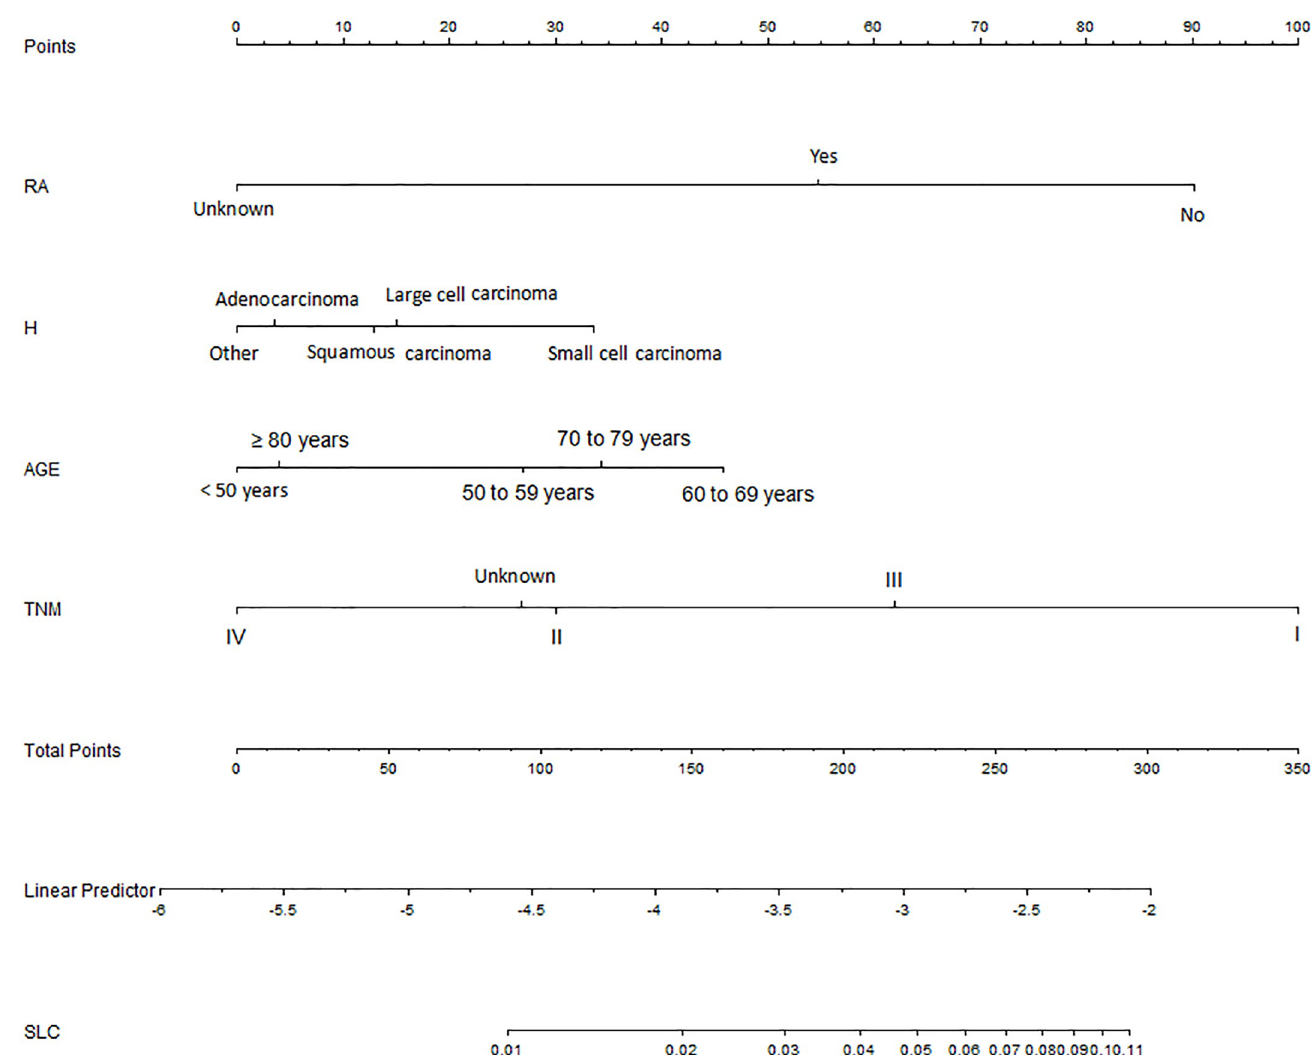
Fig 2. Risk prediction nomogram of metachronous second primary lung